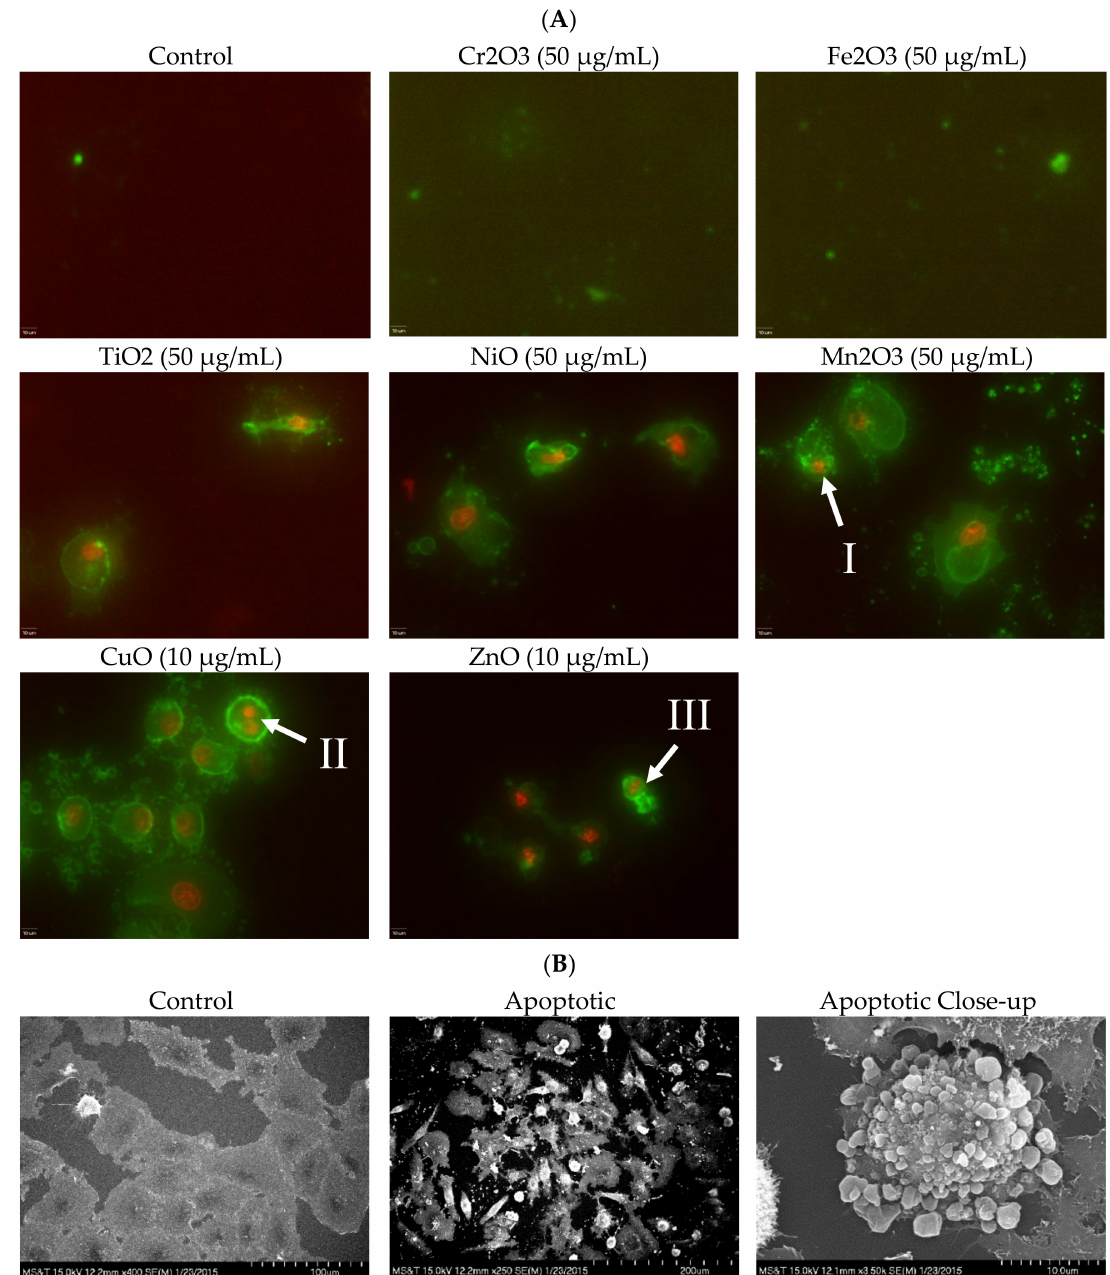
Figure 3. ( A ) Fluorescence apoptotic stains with Annexin V-FITC and 7-aminoactinomycin D (7-AAD) after cells were exposed to nanoparticles at 50 or 10 µ g / mL. Green color alone indicates cells undergoing early apoptosis. Red and green in combination indicate cells undergoing late apoptosis. Examples of (I) blebbing, (II) nuclear fragmentation, and (III) apoptotic bodies are marked. Scale bar is 10 µ m. ( B ) SEM images of A549 cells after exposure to 50 µ g / mL MnO. Membrane blebbing is quite noticeable in the close-up